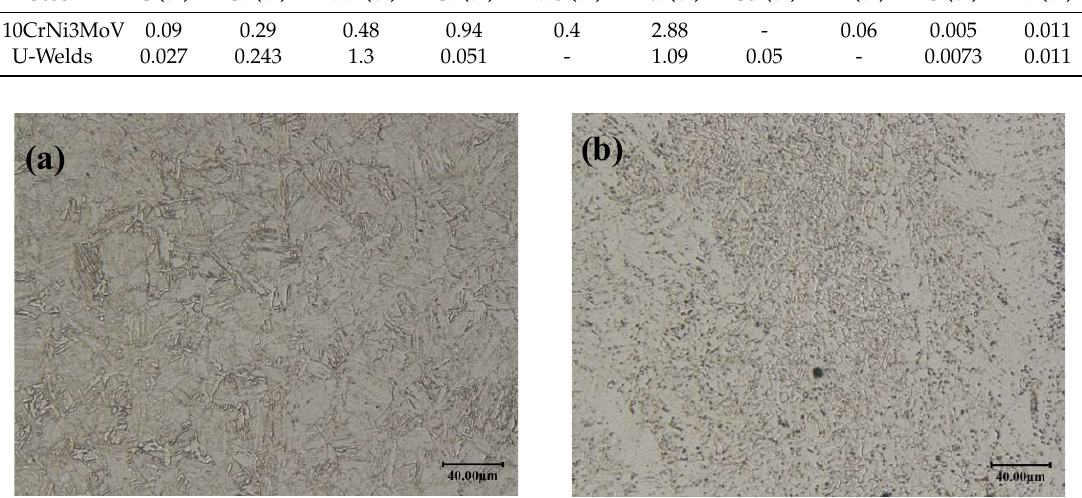
Figure 1. Microstructures of the investigated materials: ( a ) 10CrNi3MoV high strength steel; ( b ) undermatched welds.